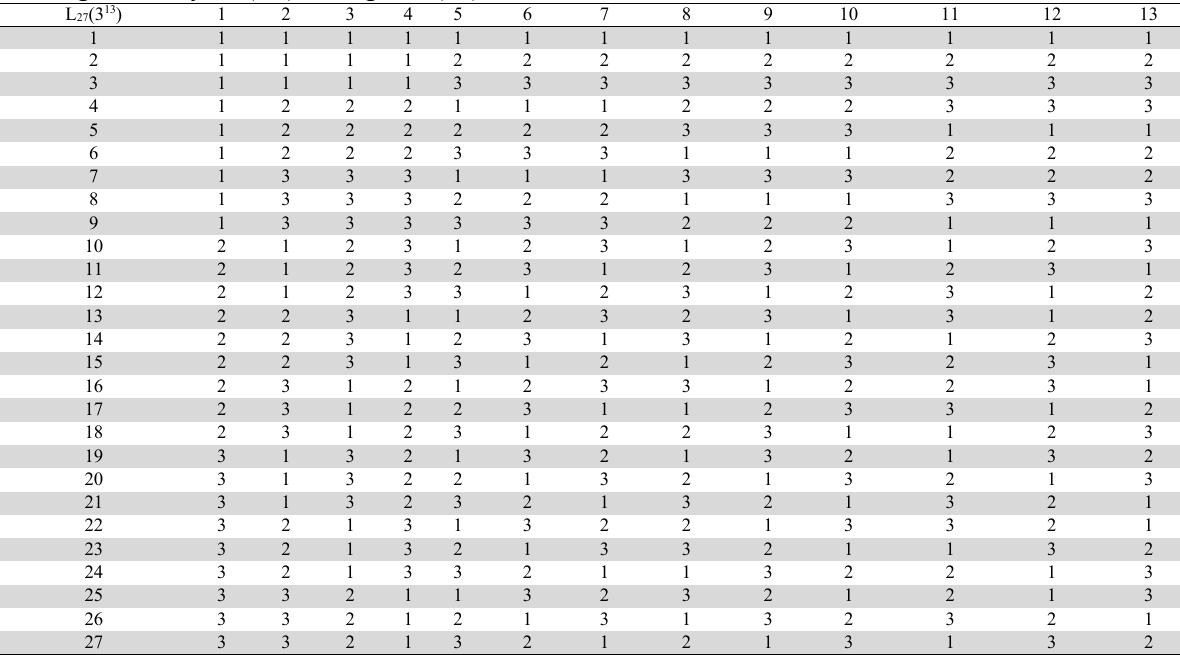
Orthogonal arrayL 27 (3 13 ) of Taguchi (33).